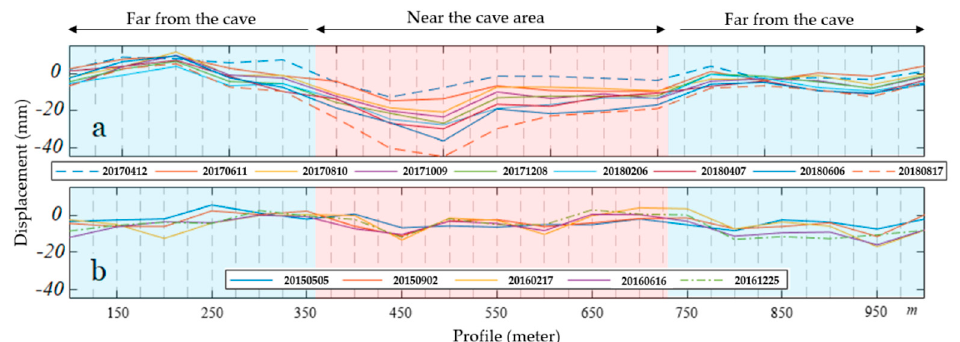
Figure 8. One-kilometer profile of the ground’s deformation passing through the cave; ( a ) profile of the second group from January 2017 to August 2018 and, ( b ) profile of the first group from January 2015 to December 2017. The vertical axis represents the millimeter displacement, and the horizontal axis of the profile is plotted in meters. Table 3. Characteristics of three regions whose time-series behavior was analyzed.